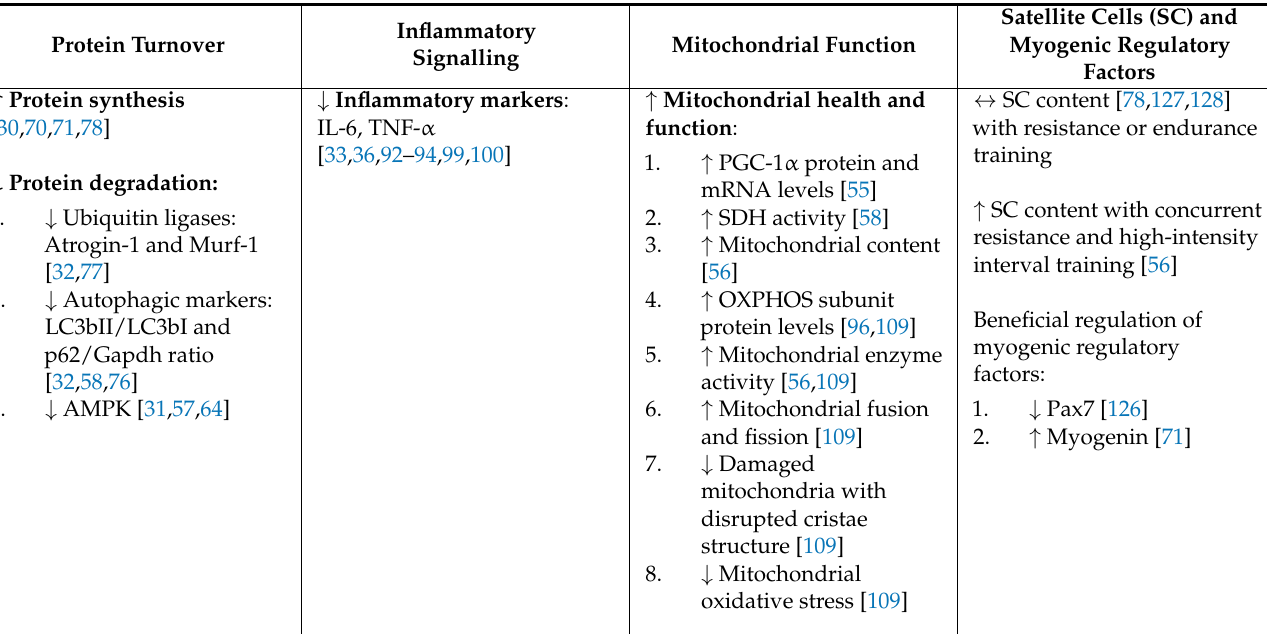
Figure 1. Beneficial effects of exercise training on counteracting the deleterious mechanisms of cancer cachexia (CC). Table 1. Effects of exercise training on cancer cachexia (CC) mechanisms.